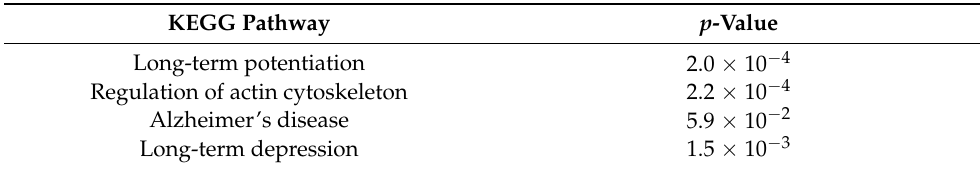
Table 5. KEGG pathway of genes differentially expressed in hippocampus of GABA-administered mice.